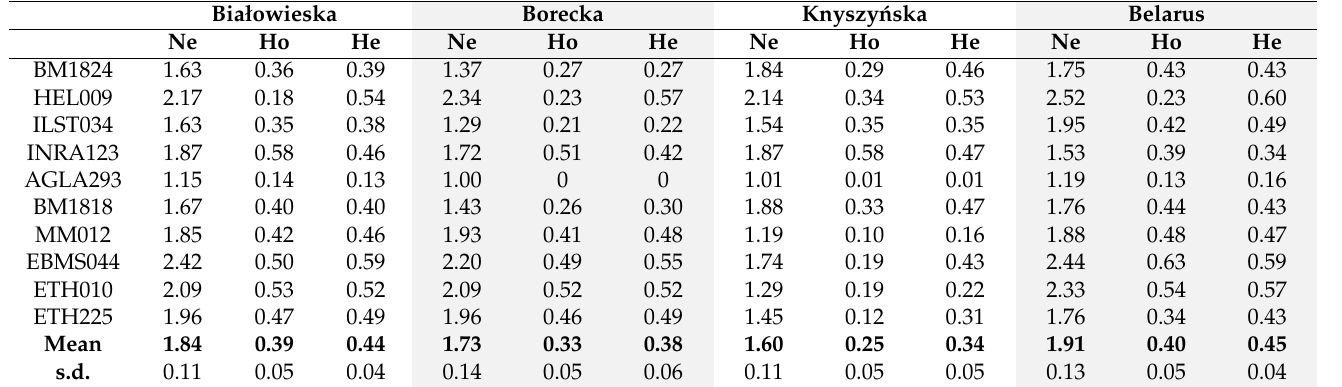
Table 4. Heterozygosity and effective number of alleles in four populations belonging to the Lowland (LB) line.